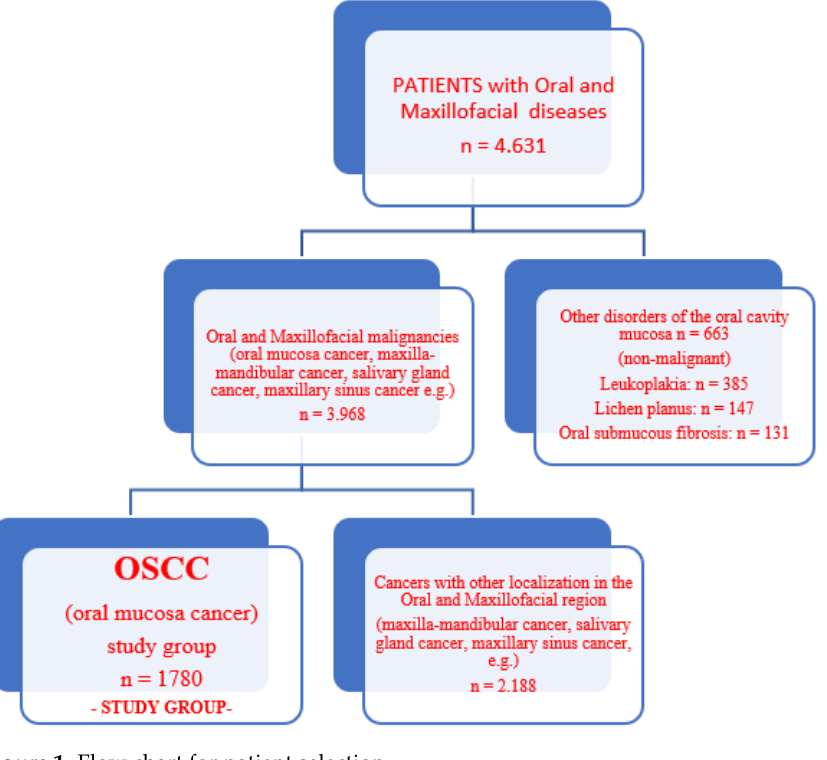
Figure 1. Flow chart for patient